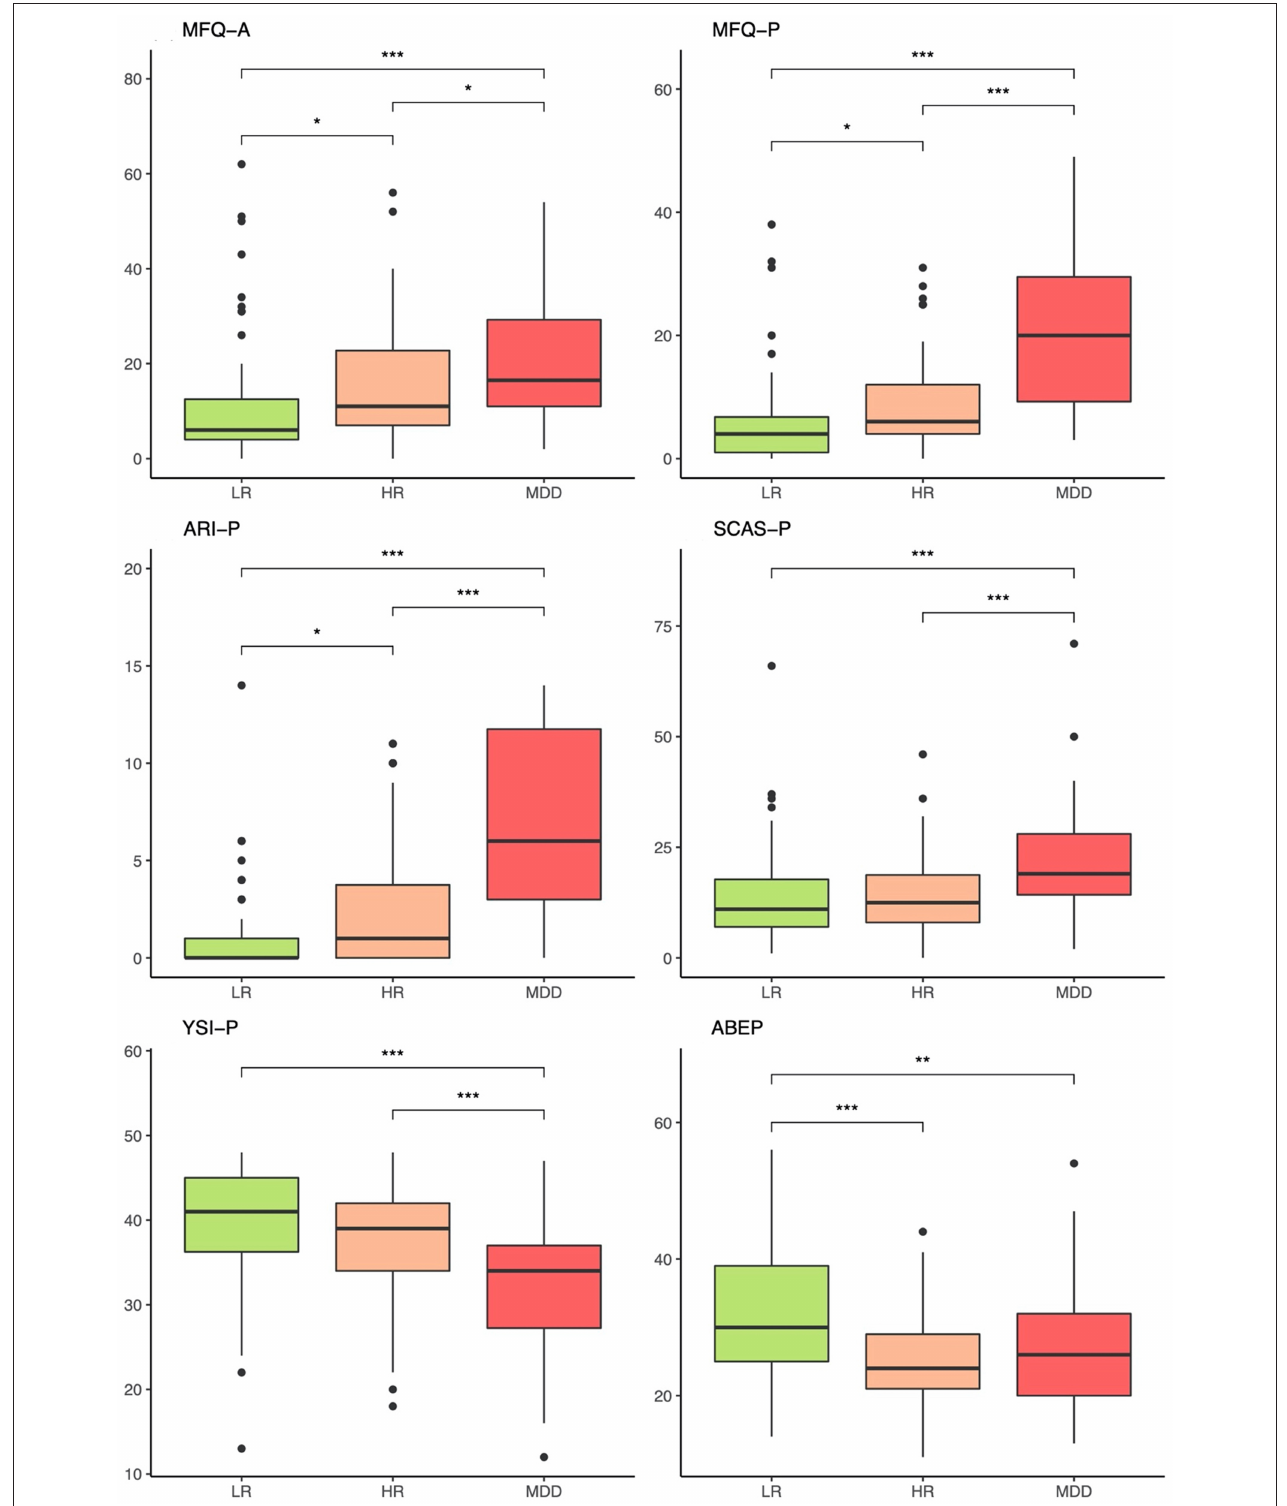
FIGURE 9 | Phenotypic comparisons between groups based on reports by the caregivers. LR, low-risk; HR, high-risk; MDD, major depressive disorder; MFQ-A, Mood and Feelings Questionnaire—Adult (caregiver self-report); MFQ-P, Mood and Feelings Questionnaire—Parent (caregiver report on adolescent); ARI-P, Affective Reactivity Index—Parent; SCAS-P, Spence Children’s Anxiety Scale—Parent; YSI-P, Youth Strengths Inventory—Parent; ABEP, Brazil socioeconomic classification index. The non-parametric Kruskal-Wallis test was applied to compare the means. * p < 0.05, ** p < 0.01, *** p < 0.001.